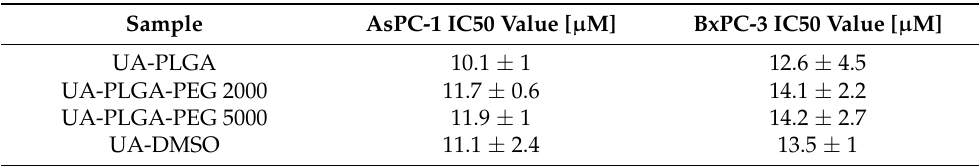
Table 2. IC50 values for encapsulated and non-encapsulated ursolic acid on two PDAC cell lines, AsPC-1 and BxPC-3.